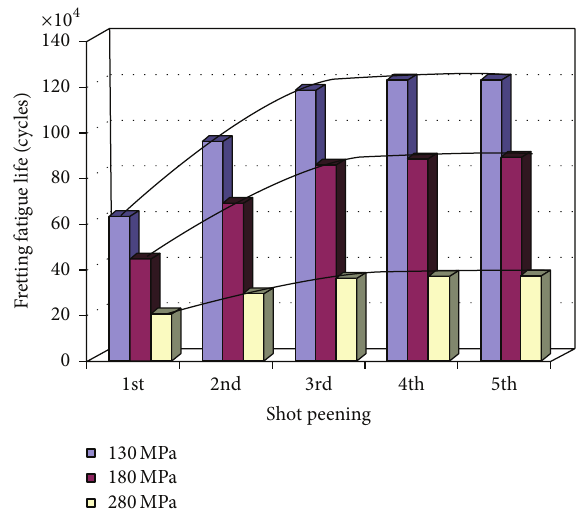
Figure 12: Variation of fatigue life versus the number of reshot peenings for different maximum stresses